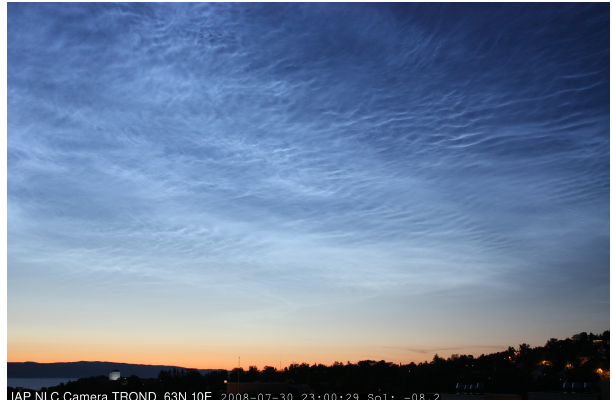
Figure 1. Noctilucent cloud observed by camera from Trondheim on 30 July 2008 at 23:00UT.